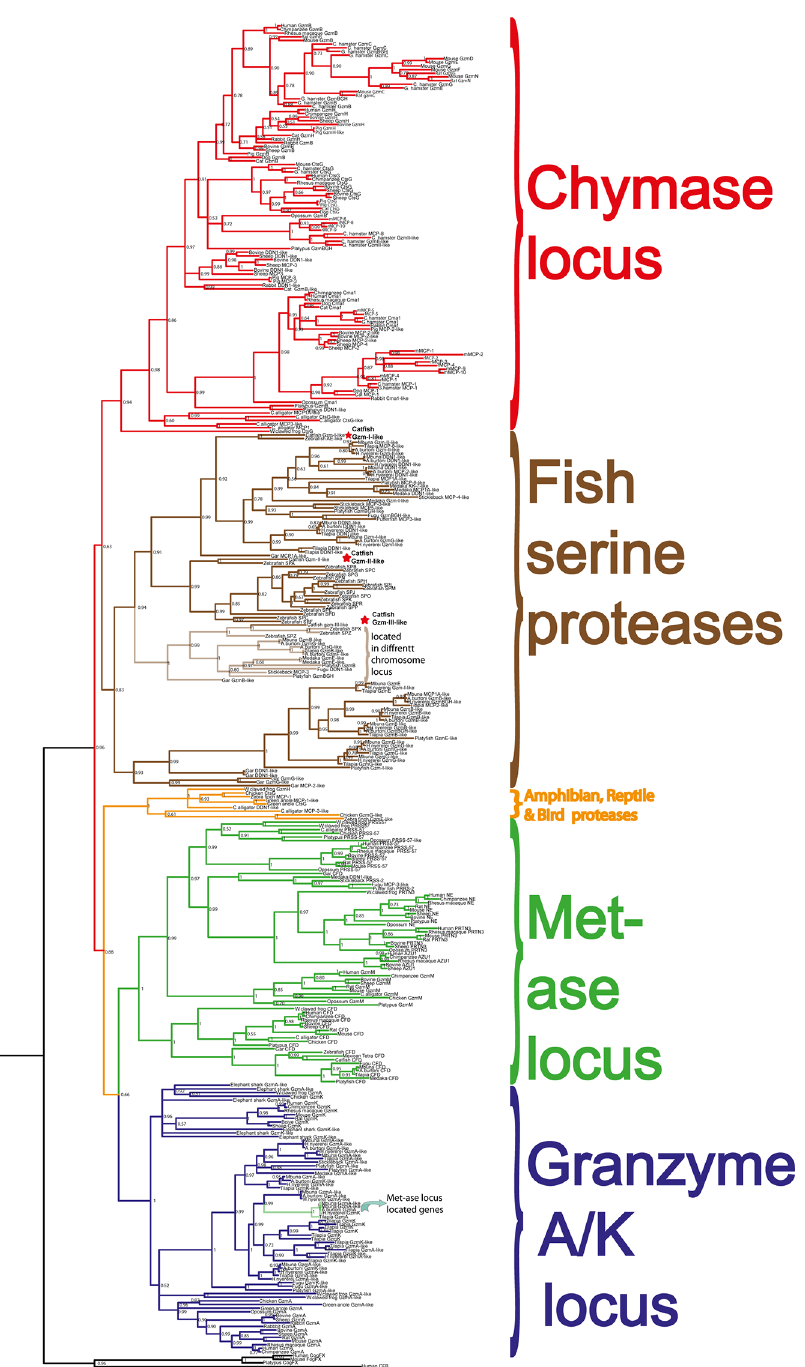
Fig 6. Phylogenetic analysis using the MrBayes algorithm. The original tree includes many members that cannot easily be displayed on one page. The individual parts of the tree have therefore been enlarged and presented separately (Figs 7 – 10) for the chymase locus-related genes, the fish chymase-related genes, the met-ase locus genes and the granzyme A/K locus genes, respectively. The chymase locus-related fish genes that are found within the met-ase locus (Fig 10) are marked by green instead of blue. Human and mouse coagulation factor X and complement factor B have been used as outgroups to get a more distinct topology of the tree. The three catfish serine proteases that are under more detailed biochemical analyses are marked by red stars in Fig 9. They represent three of the four major sub-branches of fish chymase-locus related serine protease genes. The posterior probability values are shown at each branch point in the